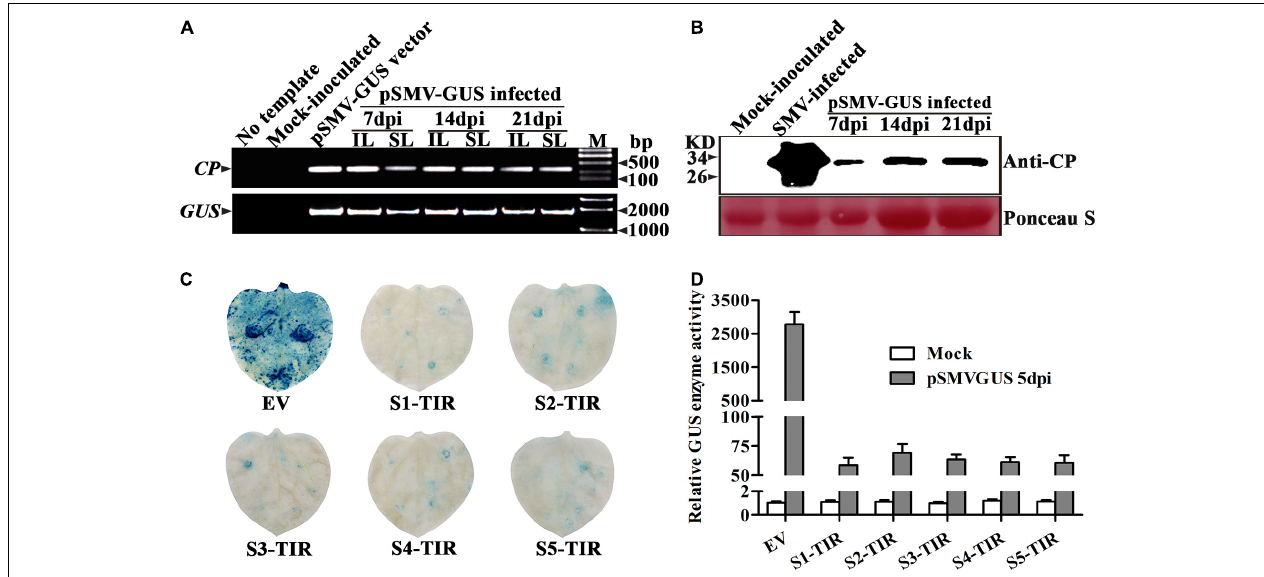
FIGURE 1 | Systemic infection of recombinant SMV cDNA construct pSMV-GUS in Nicotiana Benthamiana plants and detection of pSMV-GUS accumulation in N. benthamiana leaves expressing S1-TIR to S5-TIR. (A) Detection of viral nucleic acid in inoculated and systemic leaves of N. benthamiana plants by RT-PCR. IL: inoculated leaves, SL: systemic leaves. (B) Western blot confirmed the presence of CP protein in the systemic leaves of N. benthamiana plants at 7, 14, and 21 dpi, respectively. (C) GUS histochemical staining of the inoculated leaves of N. benthamiana at 5 dpi. (D) GUS enzyme activity analysis of inoculated leaves infiltrated by different TIR constructs at 5 dpi. EV: empty vector, TIR: target-inverted-repeat, S1-TIR to S5-TIR represent the respective TIR constructs. Mock: 0.01 M phosphate buffer inoculation as control. The error bars indicate SD calculated from three biological